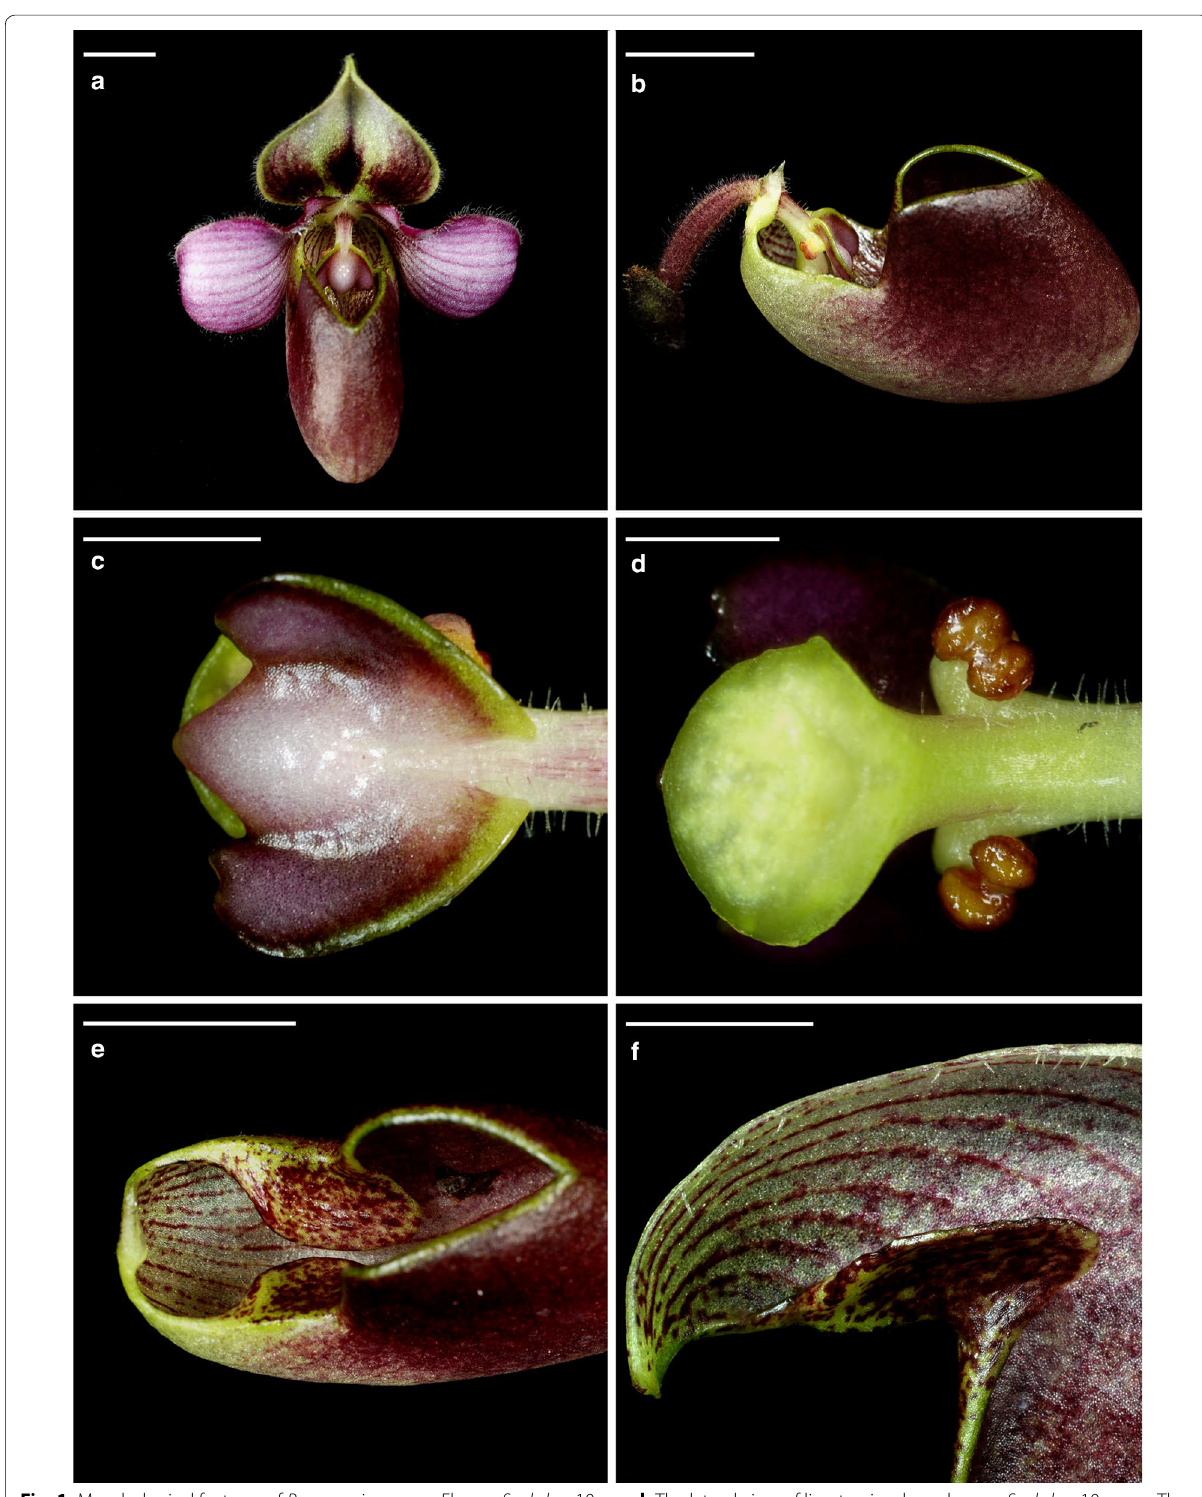
Fig. 1 Morphological features of P. rungsuriyanum . a Flower. Scale bar 10 mm. b The lateral view of lip, staminode and ovary. Scale bar 10 mm. c The staminode. Scale bar 5 mm. d The smooth stigmatic surface. Scale bar 2 mm. e Lip. The visible incurved smooth lateral lobes. Scale bar 10 mm. f The trichome arrangement. Scale bar 5